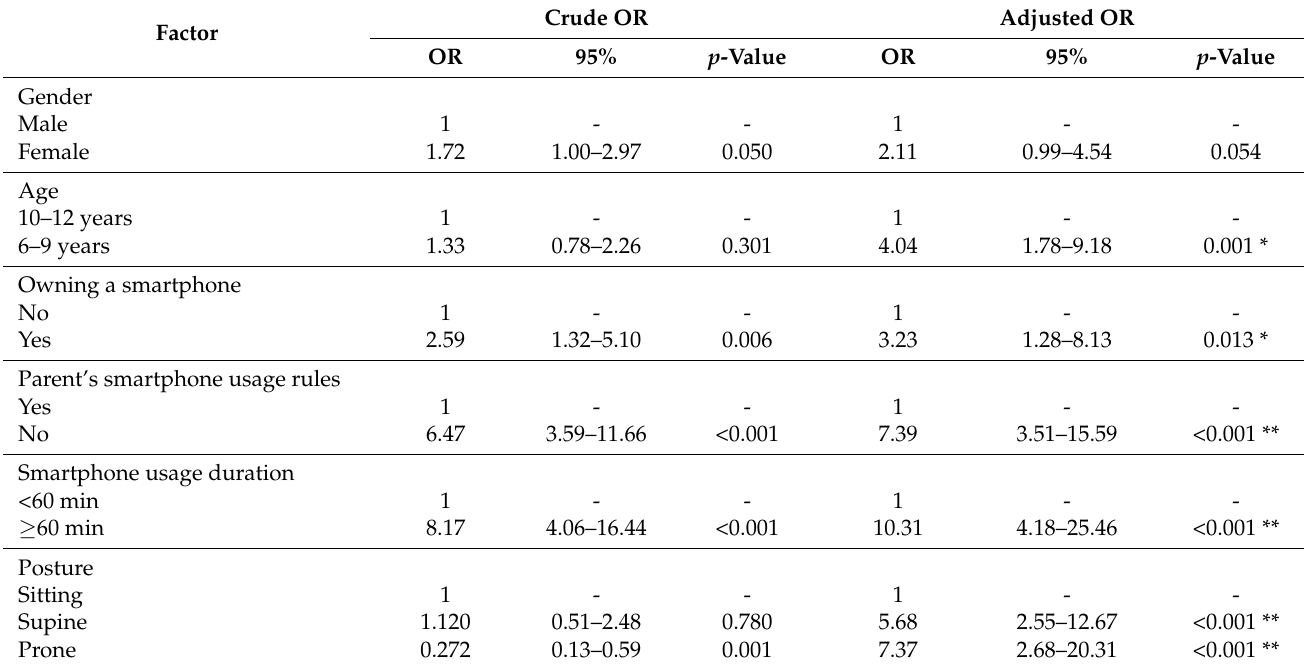
Table 4. Logistic regression analysis for musculoskeletal